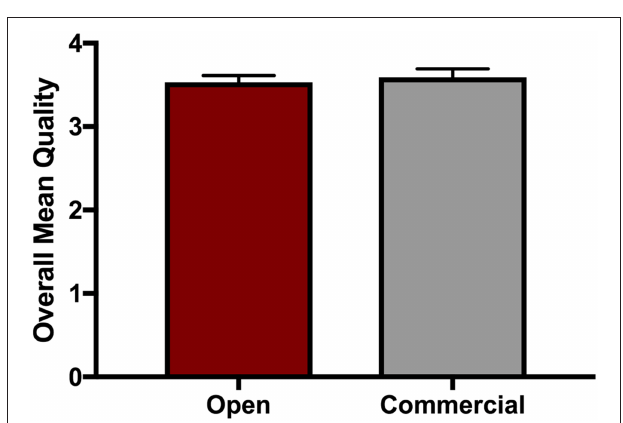
FIGURE 3 | Ratings of overall textbook quality across textbook group. Bars depict means, error bars represent standard errors of the mean.